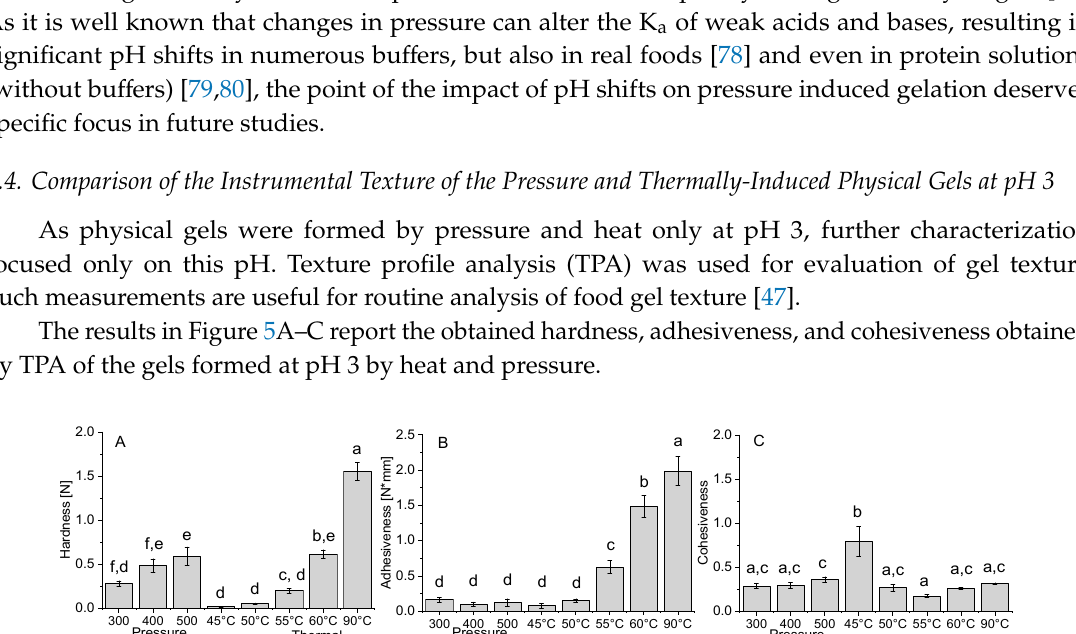
Table 1. The slope (n) and constant (k) of the mechanical spectrum fitting to Equation (2) of the thermally and pressure induced gels.